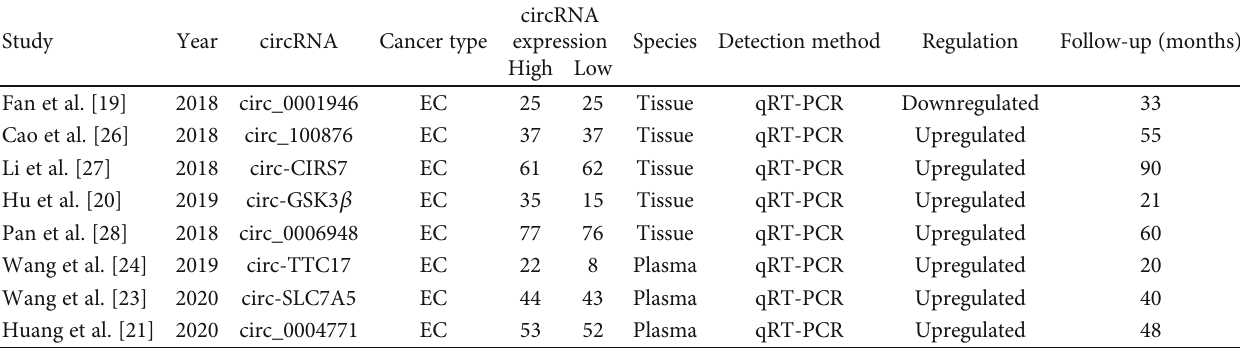
Table 2: Main characteristics of studies for prognosis analysis.